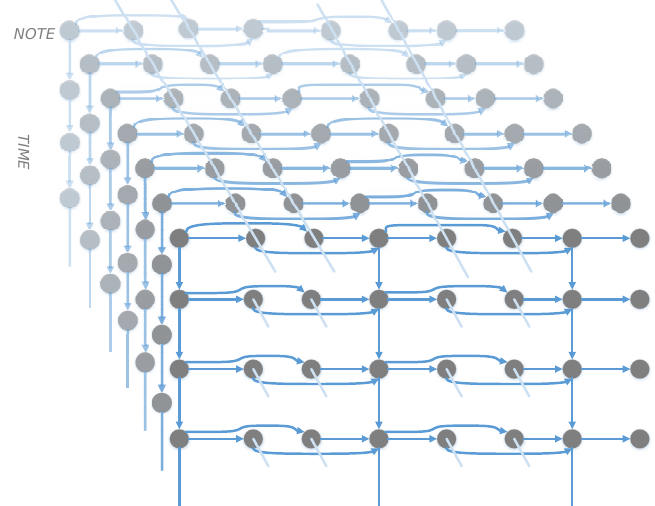
Figure 6. The architecture of 3D-SCN: three-dimensional sequential convolutional network.